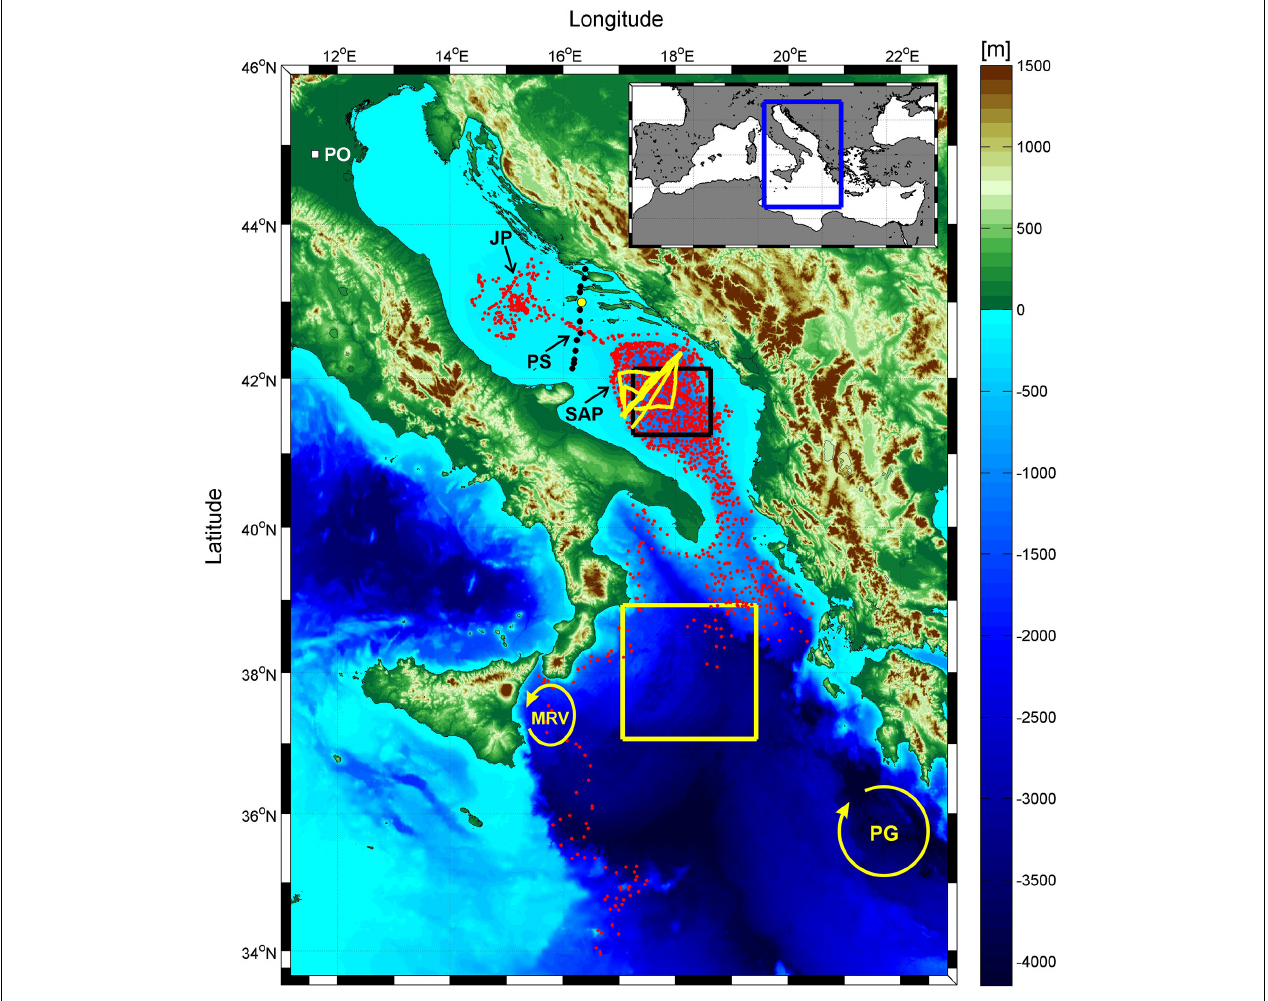
FIGURE 1 | The bathymetry of the Adriatic-Ionian basin. The positions of Argo profiles used in the study are denoted by small red dots. CTD stations at the Palagruža Sill transect are indicated by black dots, with Stonˇcica station (CJ009) denoted by larger yellow dot. Glider trajectories in the Southern Adriatic are marked by yellow lines. JP, PS and SAP stand for the Jabuka Pit, the Palagruža Sill and the South Adriatic Pit, respectively. The black rectangle in the Southern Adriatic indicates the area over which heat and water fluxes were estimated. The yellow rectangle in the Northern Ionian represents the area used for computation of vorticity. The positions and the sense of rotation of the Messina Rise Vortex (MRV) and the Pelops Gyre (PG) are also indicated. Pontelagoscuro station, at which Po River discharge are measured, is indicated by the white square in the upper left part of the